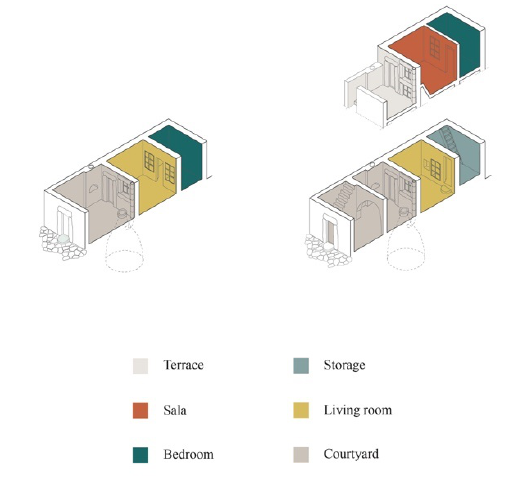
Figure 6. One and two storey house.